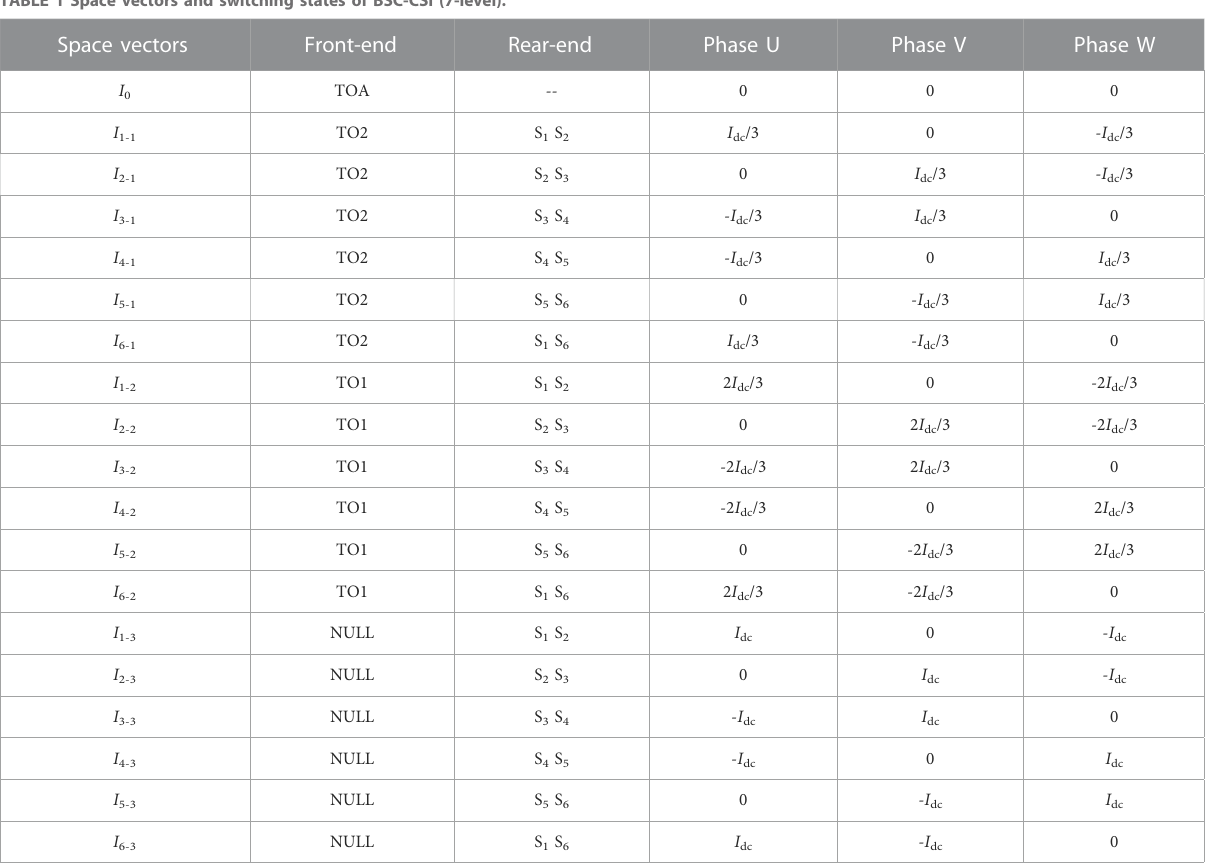
TABLE 1 Space vectors and switching states of BSC-CSI (7-level). Space